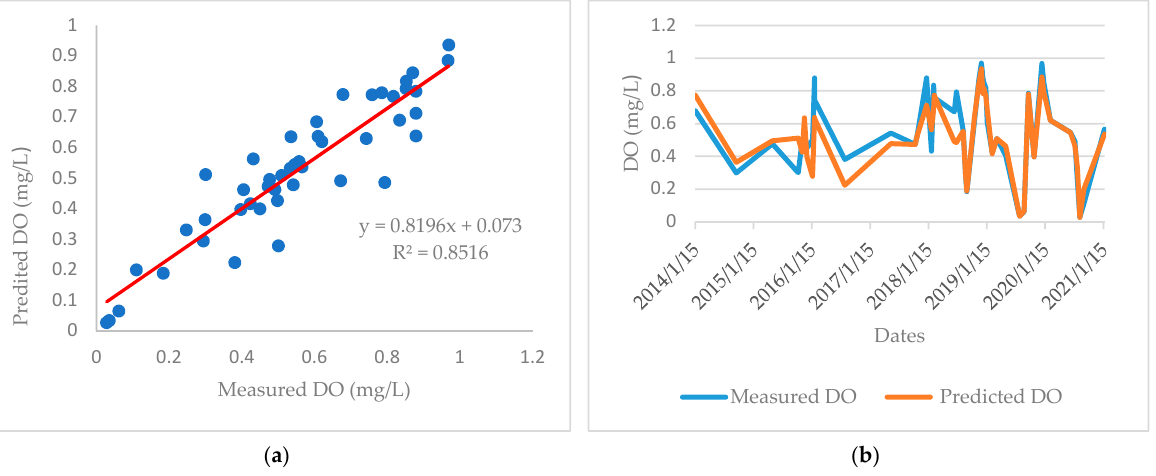
Figure 5. Comparison between experimental DO data and those obtained by the proposed MLR model. ( a ) Correlation between measured and predicted DO; ( b ) Date profile of measured and pre- dicted DO.